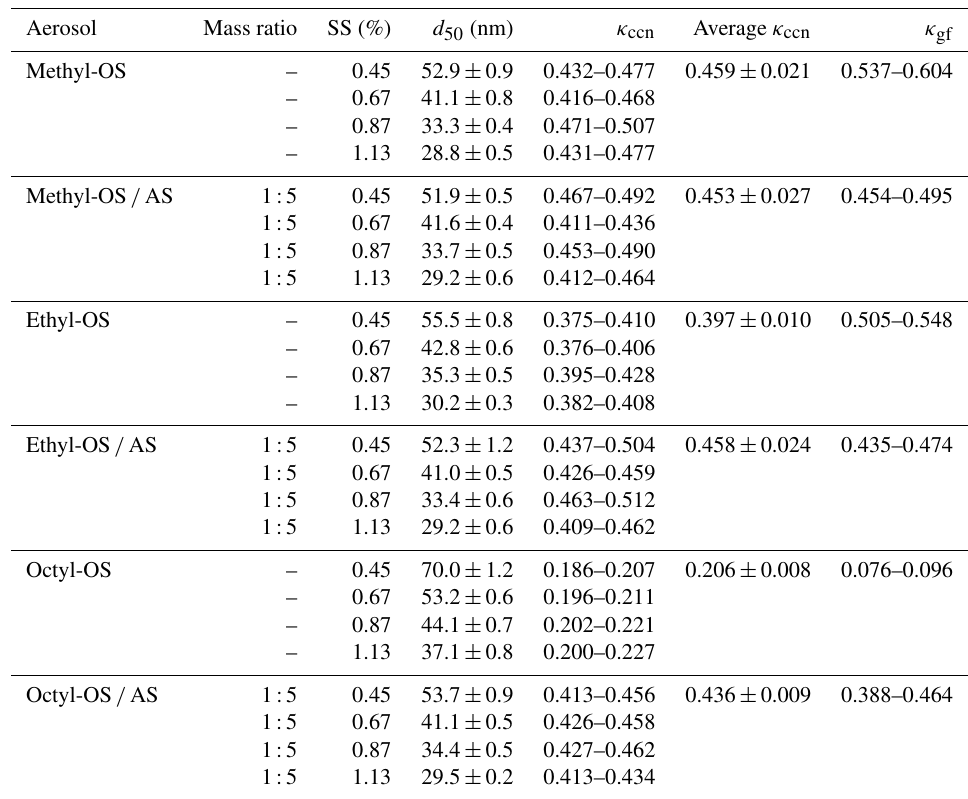
Table 5. Single hygroscopicity parameters derived from hygroscopic growth ( κ gf ) and CCN activity measurements ( κ ccn ) for methyl-, ethyl- and octyl-OS and their internal mixtures with ammonium sulfate (AS). All errors given were standard deviations. Aerosol Mass